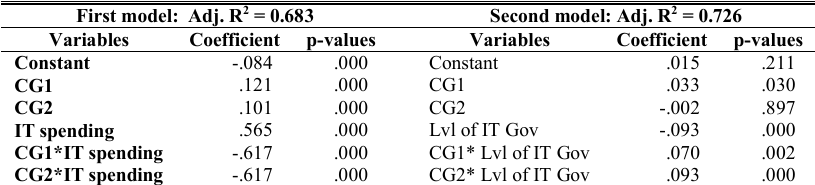
First model: Adj. R 2 = 0.683 Second model: Adj. R 2 = 0.726